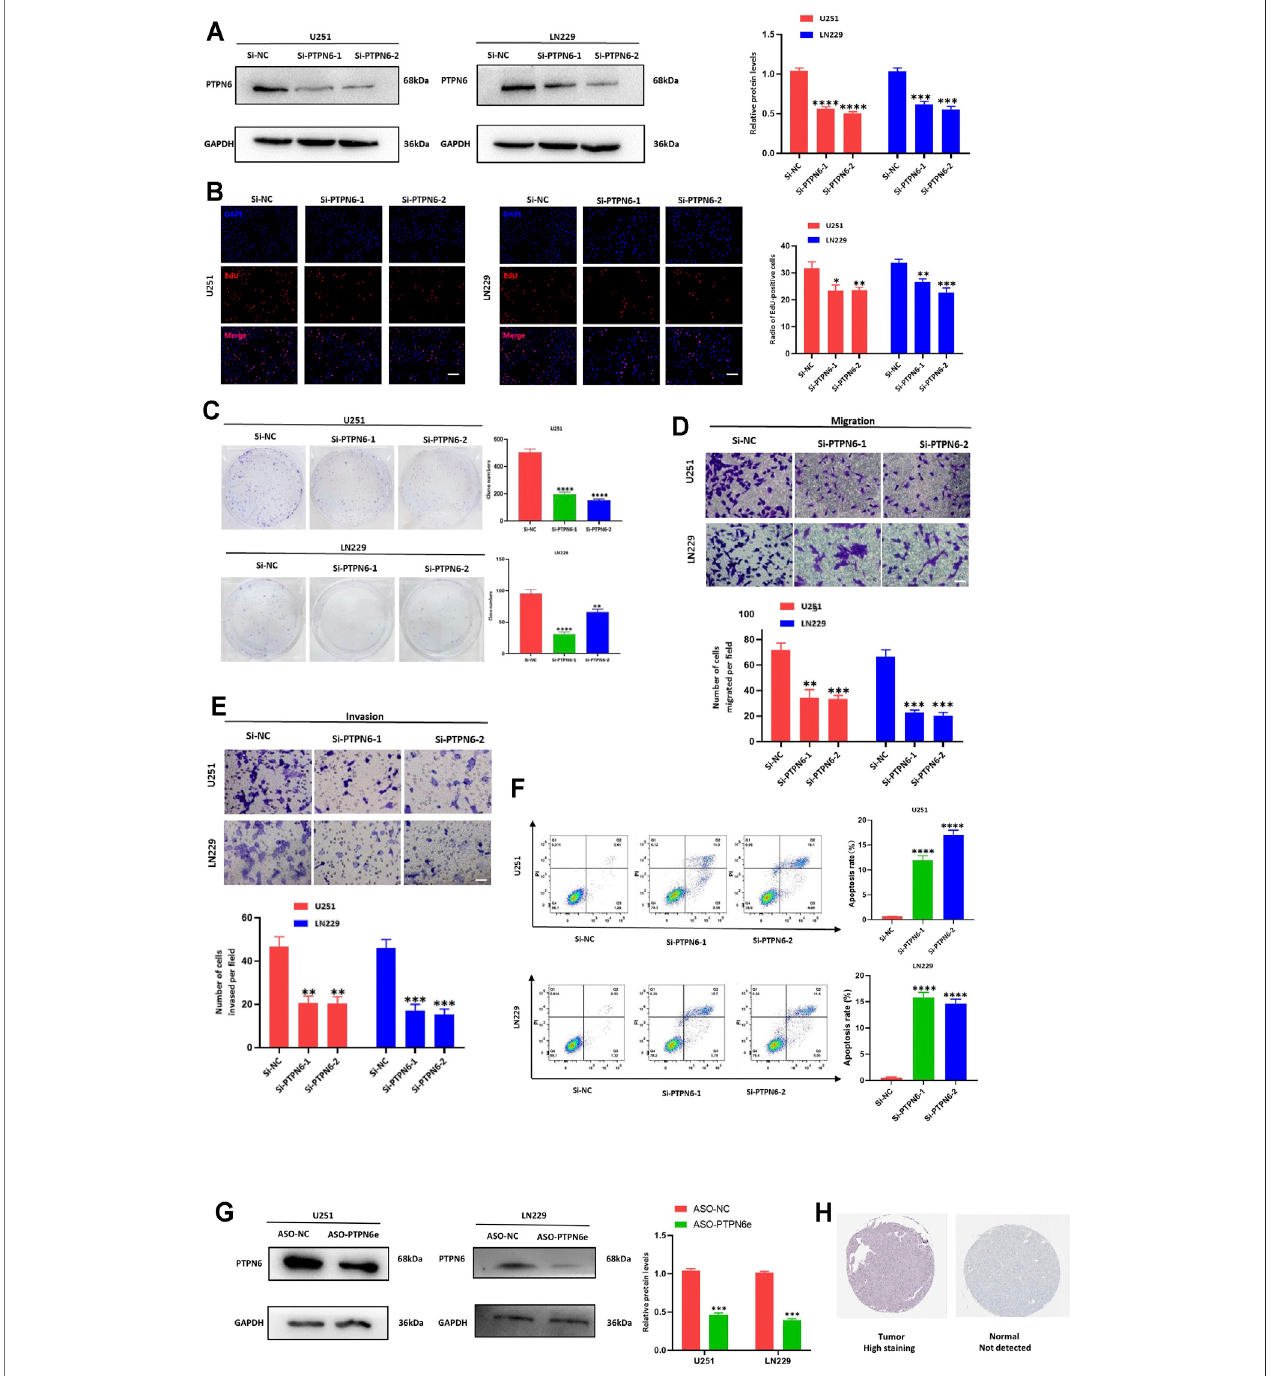
FIGURE9| KnockdownofPTPN6suppressedtheproliferation,migration,invasion,andincreasedcellapoptosisofU251andLN229cells invitro . (A) Westernblot analysis to examine the ef fi ciency of the PTPN6 knockdown. (B) EdU staining to assess proliferation ability. (C) Clonogenic assays to assess colony-forming abilities. (D,E) Transwellassaystodetectthemigrationand invasivecapacities. (F) Flowcytometry toanalyzethe apoptosisofU251and LN229cells. (G) Relativequantitationof PTPN6proteinexpressionlevelsinASO-treatedU251andLN229cells. (H) PTPN6expressioningliomatissuesandnormaltissues.Magni fi cation, × 200 (B,D,and E) . Scale bar, 100 μ m (B,D, and E) . * p < 0.05; ** p < 0.001; *** p < 0.001; **** p < 0.0001. Data are shown as mean ± SD at least three independent experiments.